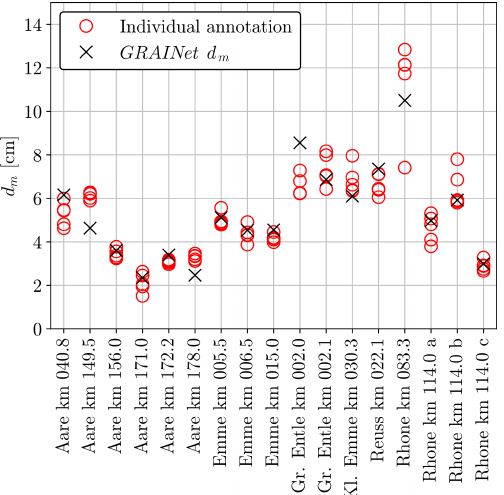
Figure 16. Variation of d m annotated by three to five different hu- man experts, compared to end-to-end d m regression of GRAINet .